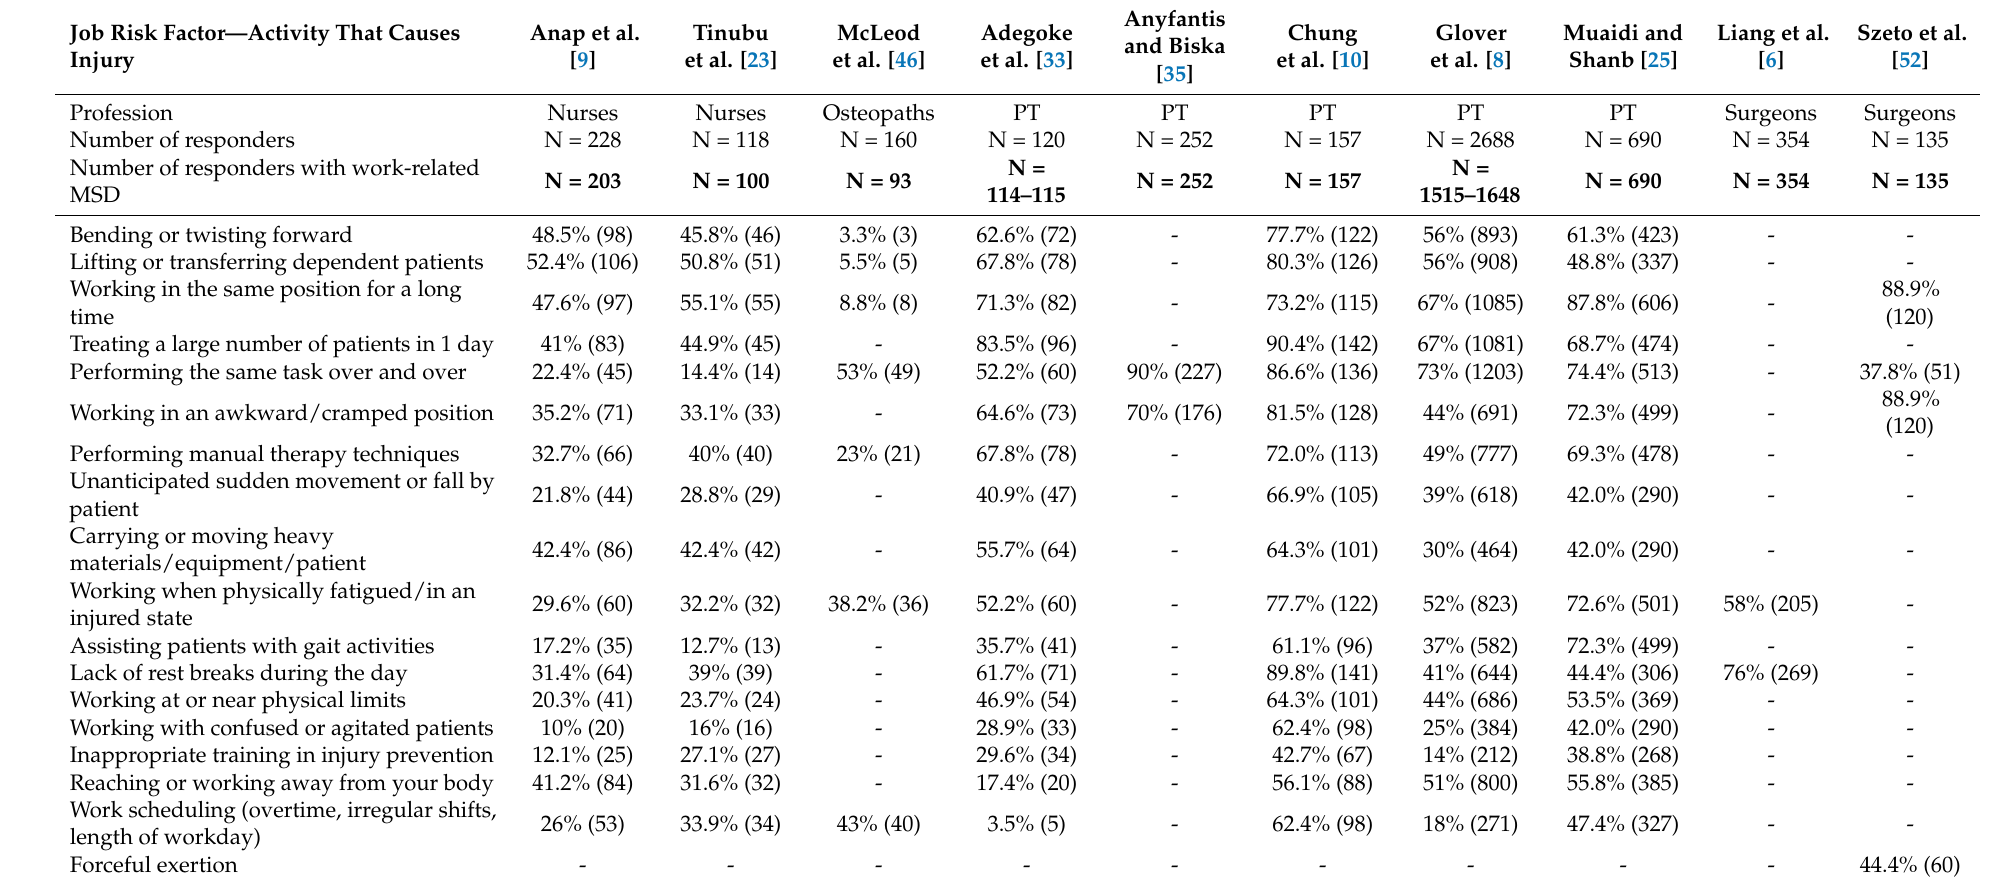
Table A2. Job risk factors identified for all healthcare professionals (percentage of sample and corresponding number of participants in